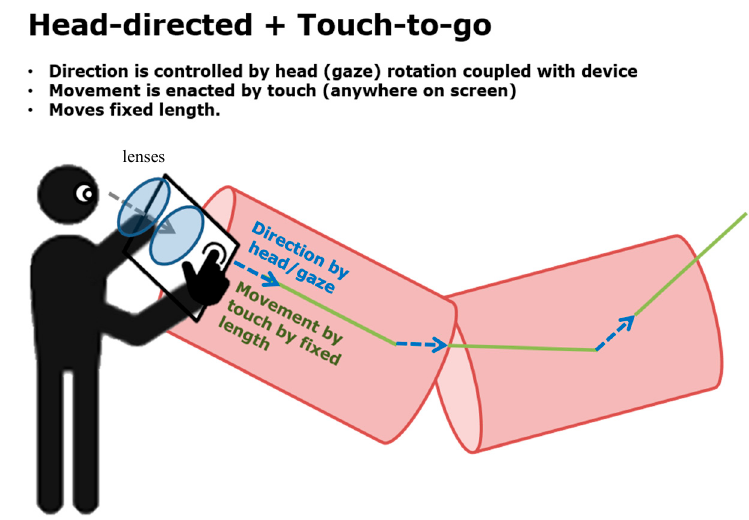
Figure 2. The head-directed, touch-to-go interface (HD + TG). The red cylinders represent the virtual tunnel segments through which the user needs to navigate in the experimental task. The gaze is estimated by the orientation of the hand-held smartphone and sets the movement direction. A single touch on the screen enacts the virtual movement by a predefined fixed distance.